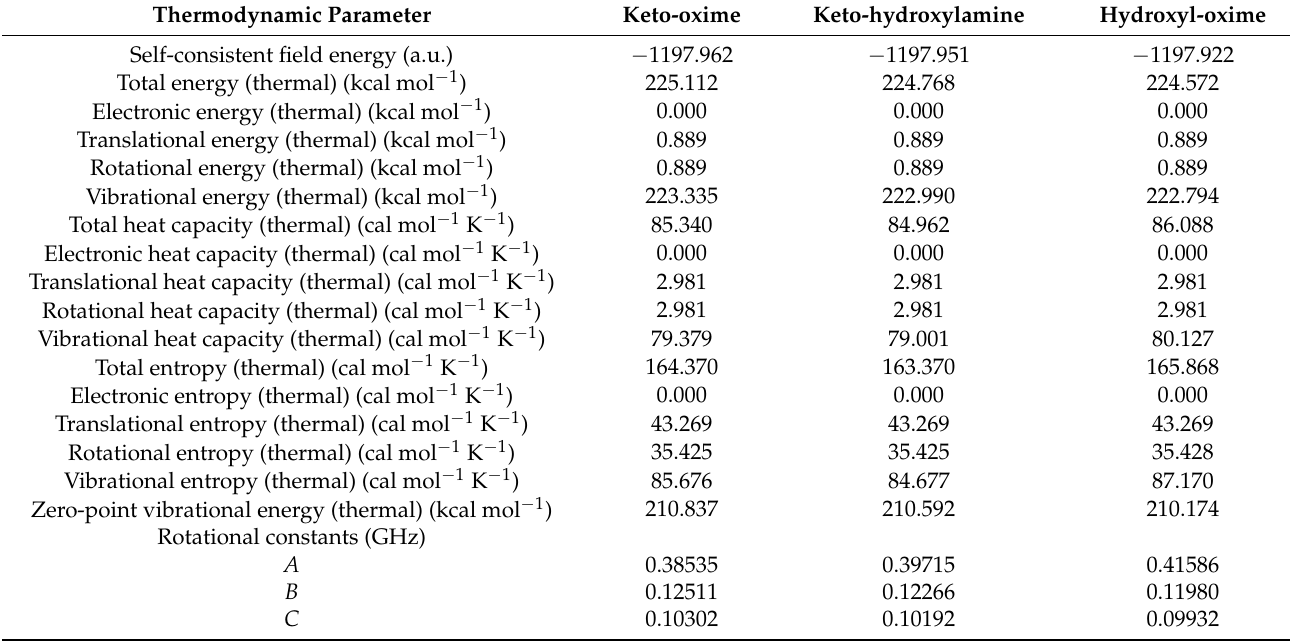
Table 1. Thermodynamic parameters of the optimized structures of the keto-oxime, keto-hydroxylamine, and hydroxyl-oxime tautomers of molnupiravir, obtained by using the DFT/B3LYP/6-311++G(d,p) method.